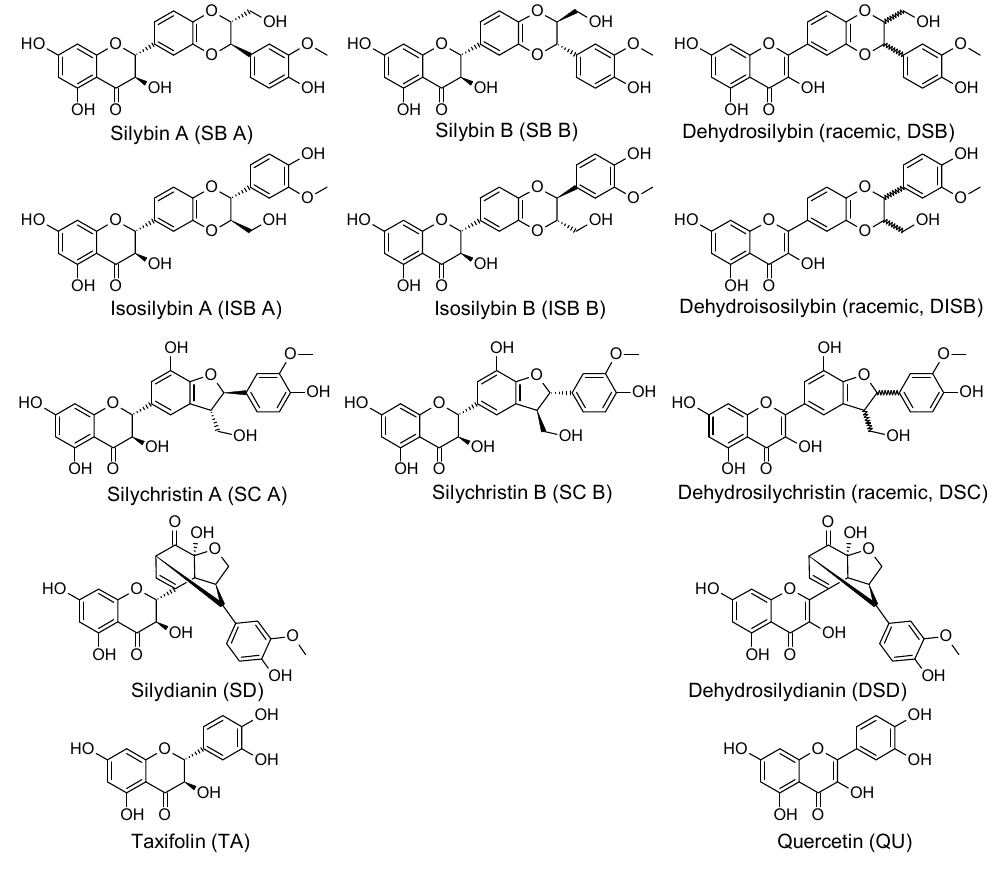
Figure 1. Structure of studied polyphenols.